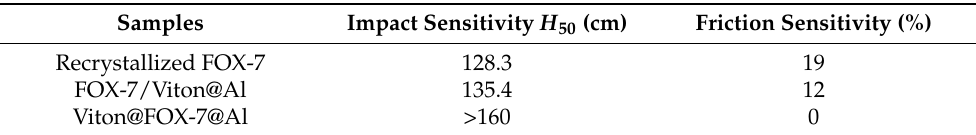
Table 3. Impact sensitivity and friction sensitivity of the